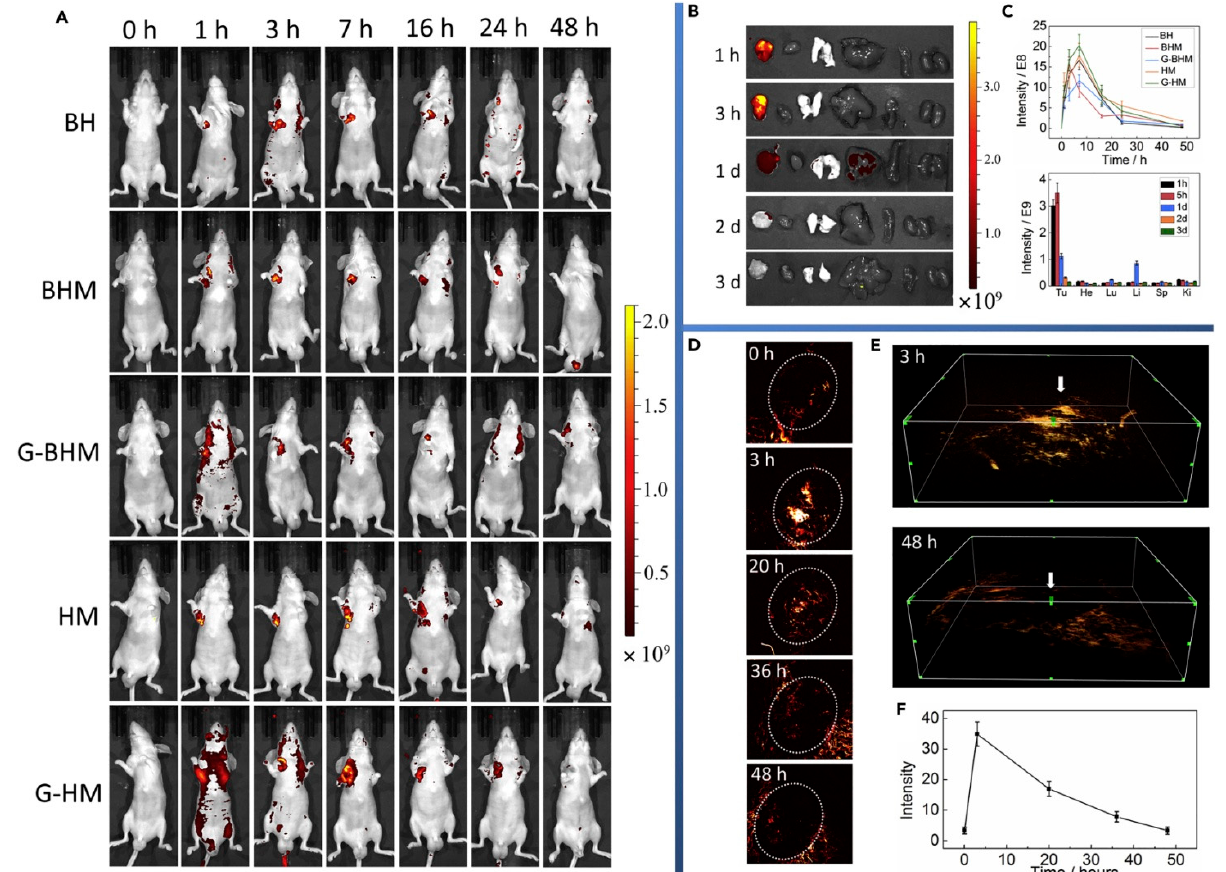
Figure 6. ( A ) Fluorescence imaging of SGC-7901 tumor-bearing model mice after intravenous injection of different materials at 7 time points. Unit of scale bar: (p/s/cm 2 /sr)/(mW/cm 2 ). ( B ) Ex vivo Fluorescence imaging of tumor, heart, lung, liver, spleen, and kidney in sequence in SGC-7901 tumor-bearing model mice after intravenous injection of G-BHM at 5 different time points. ( C ) Time-dependent in vivo integrated FL intensity for different materials (top) and in different organs (bottom). ( D ) PA imaging of SGC-7901 tumor after injection of G-BHM at different time points. ( E ) Stereoscopic PA images, and white arrow represents tumor zone. ( F ) PA signal intensity variation corresponding to part ( D ). Reprinted with permission from Ref. [66]. Copyright 2019, Elsevier Inc.